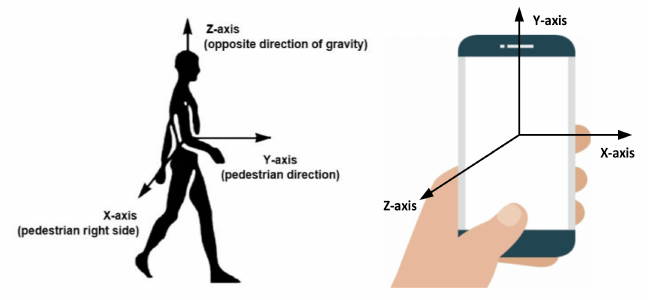
Figure 3. Schematic diagram of heading